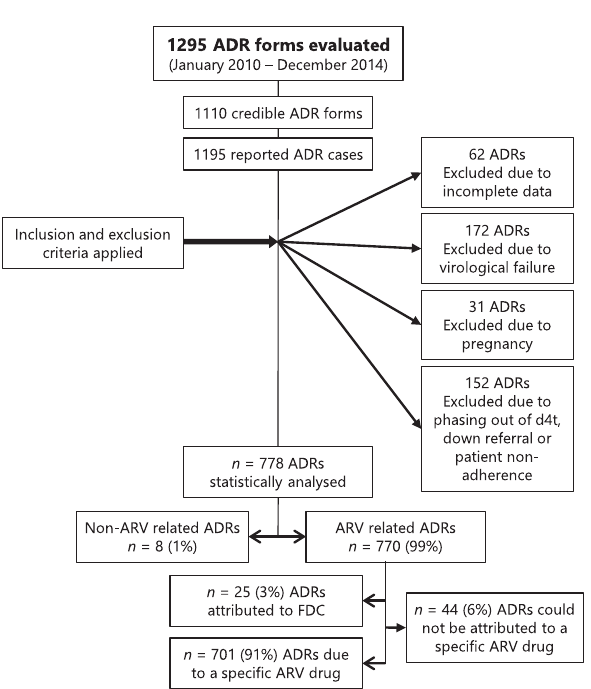
Figure 1: Flow diagram of data collected from already reported ADR forms.